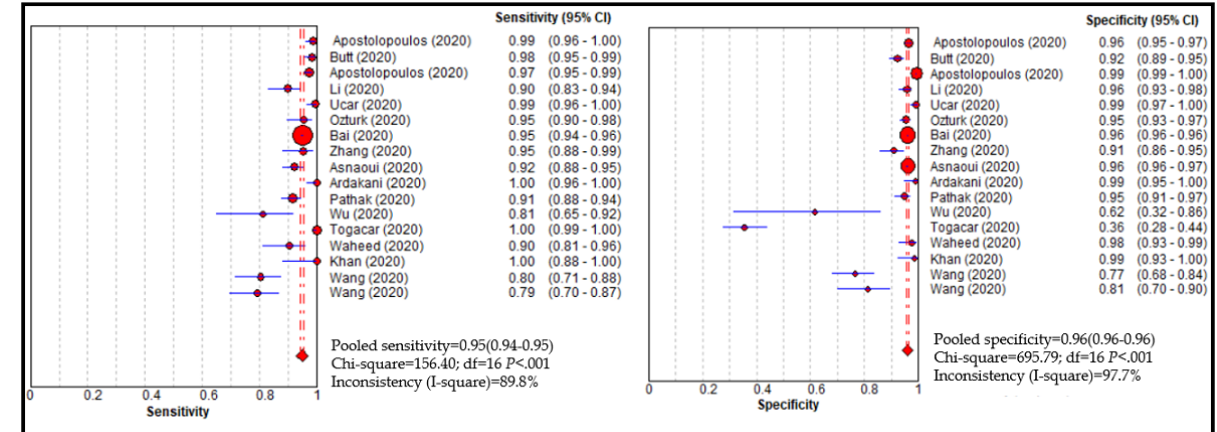
Figure 2. Performance of the deep learning model for detecting